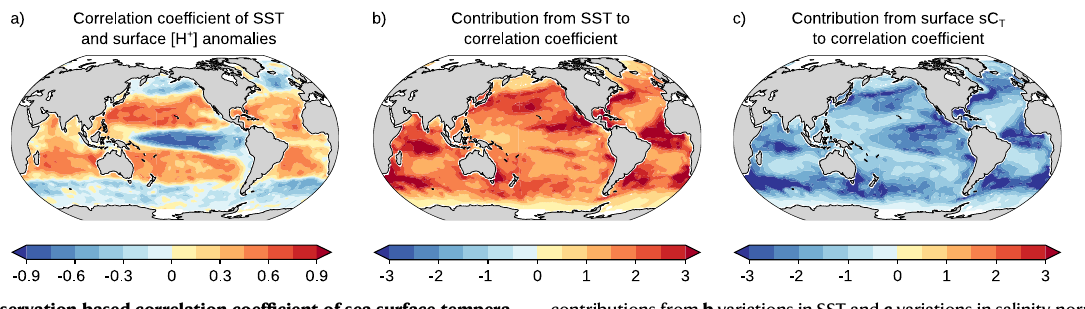
contributions from b variations in SST and c variations insalinity-normalized C T to thecorrelationcoef fi cient(thesumofpanels b and c approximatelyequalstopanel a ; see “ Methods ” ). The data were linearly detrended prior to the analysis.